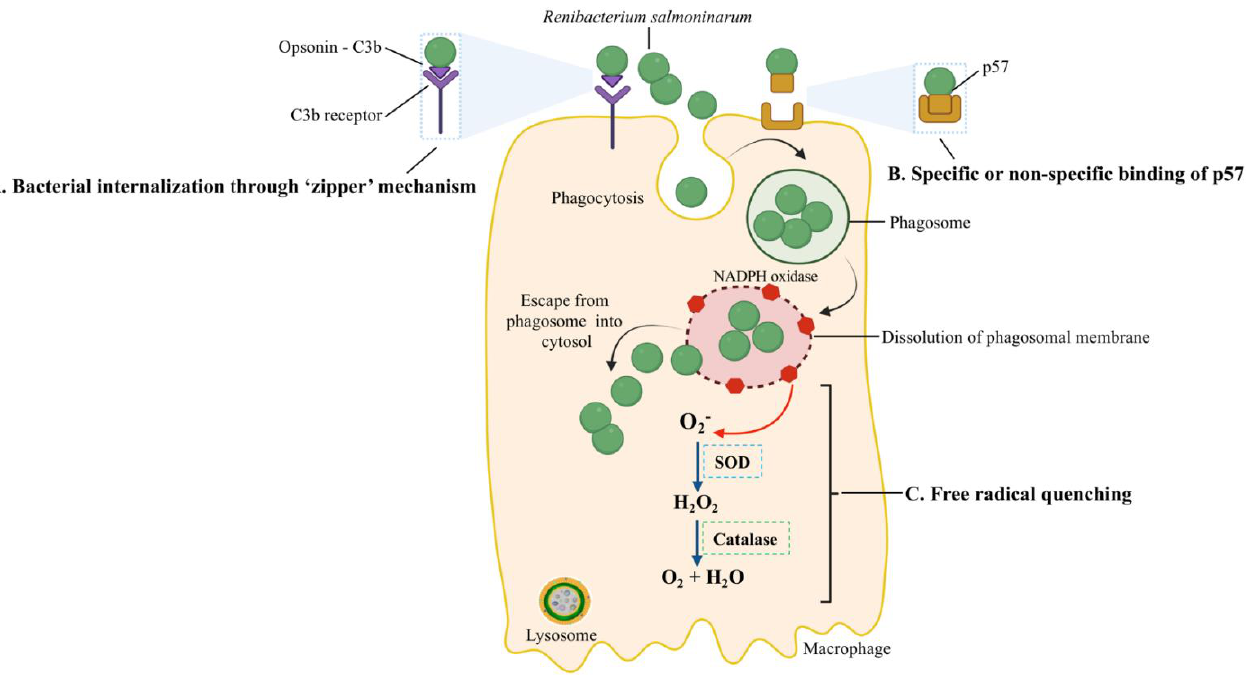
Figure 4. Host-pathogen interactions during the intracellular entry, replication, and survival of R. salmoninarum . R. salmoninarum ’s entry into macrophages is facilitated in two ways: ( A ) Bacterial internalization through a ‘zipper’ mechanism . Here, opsonin C3b binds to the bacterial surface, followed by ligation to C3b-receptor-bearing fish phagocytes and the intracellular invasion of bacteria into host cells. ( B ) Specific or non-specific binding of p57 to host cells. The hydrophobic surface protein p57, which resembles adhe- sion protein, may allow bacterial adherence to host cell receptors through specific or non-specific binding. Phagocytized R. salmoninarum escapes from the phagosome into the cytosol by budding out of the phagosome or phagosomal membrane lysis. ( C ) R. salmoninarum evades oxidative stress from reactive oxygen species by ‘free radical quenching . ’ Here, NADPH oxidase generates ROS. Superoxide (O 2 − ) is converted into H 2 O 2 and then O 2 and H 2 O by superoxide dismutase (SOD) and catalase, respectively. This original illustration was generated by the authors using BioRender (https://biorender.com/) (accessed on 17 September